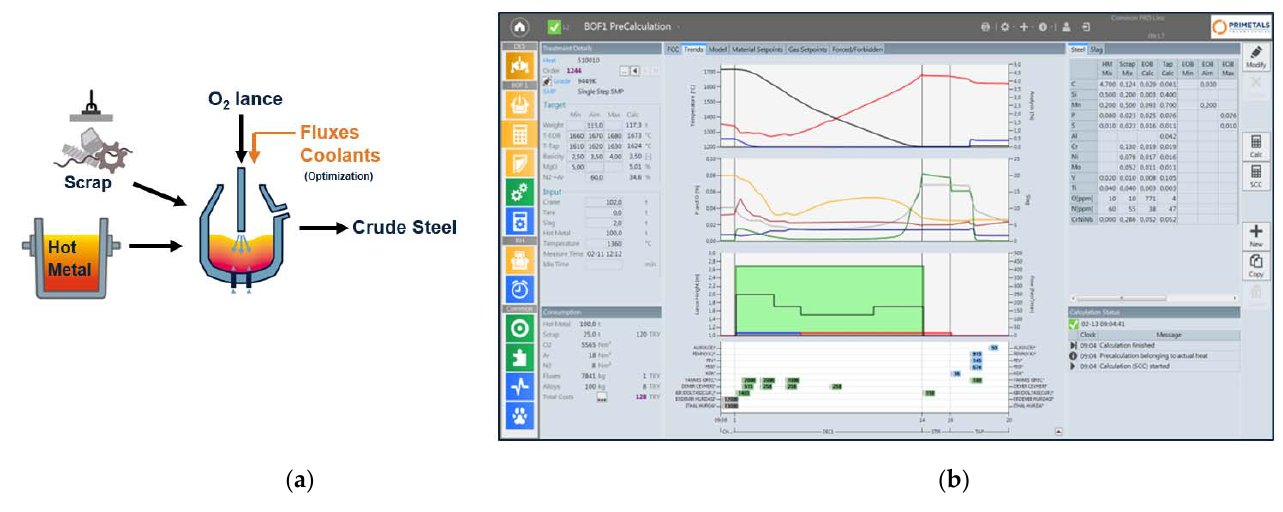
Figure 6. ( a ) Heat optimization through replacement of cooling additions with scrap. ( b ) Interface of Level 2 process model for process simulation and control. The calculated temperature (red), carbon (black), and silicon content (red) are shown in the middle-upper diagram. Slag composition, blowing pattern, and material addition schema are illustrated in the lower diagrams.